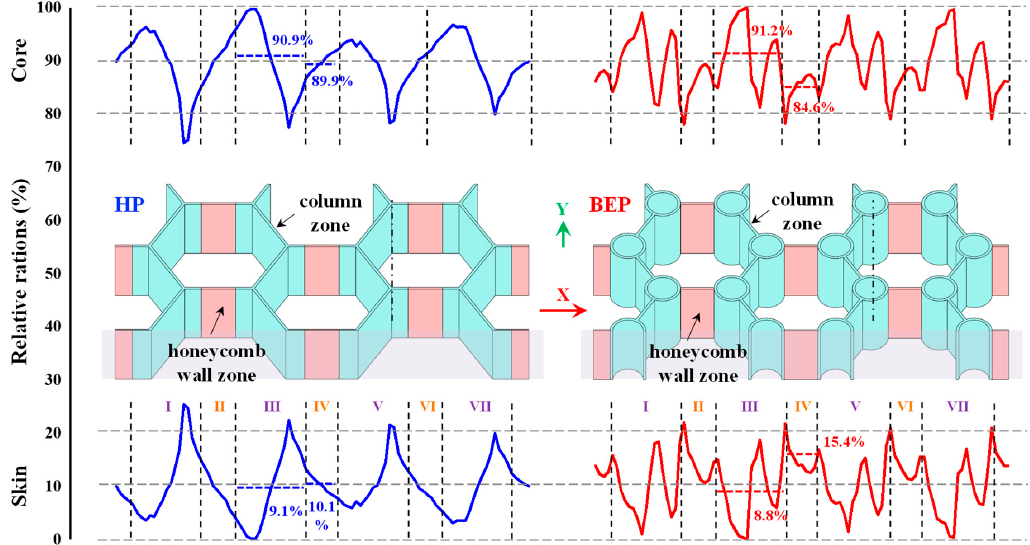
Figure 8. The FE results of the shear force proportions of the core skeleton and skin (unfilled metal HP and BEP ( η = 0.25)) (Adapted from reference [30] with permission). Upper and lower rows (blue and red curves): proportions of the shear force in the core structure and skins of the honeycomb plate and BEP. For convenience of observation, the skins are not shown, and the half-structure of the core structure along the Y-direction is displayed. The Roman numerals show column zones (purple) and honeycomb wall zones (orange).